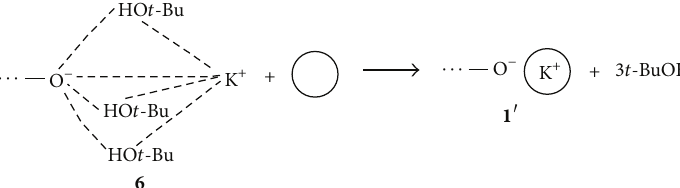
Scheme 6: Decomposition of hydrogen-bonded ion pair 6 in the presence of macrocyclic ligand.